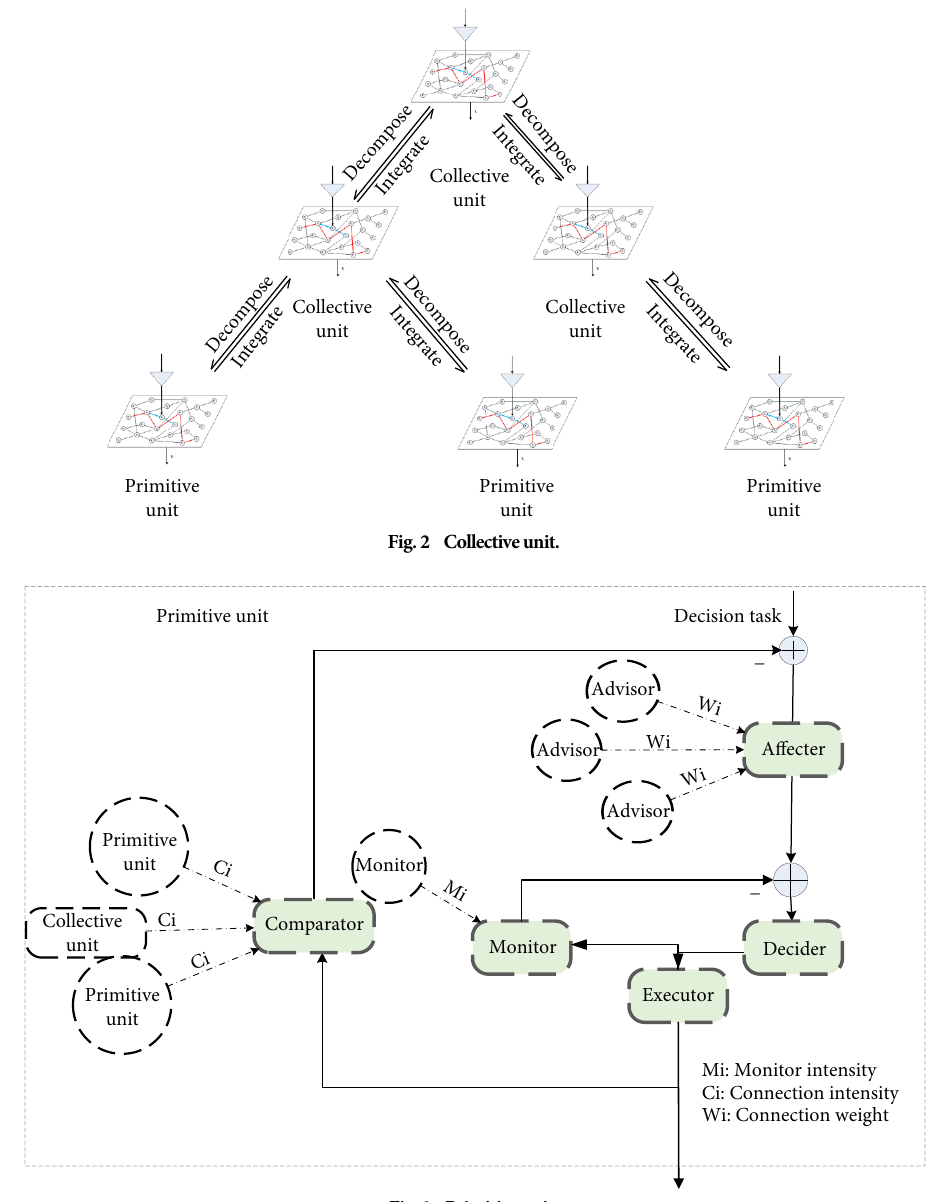
Fig. 3 Primitive